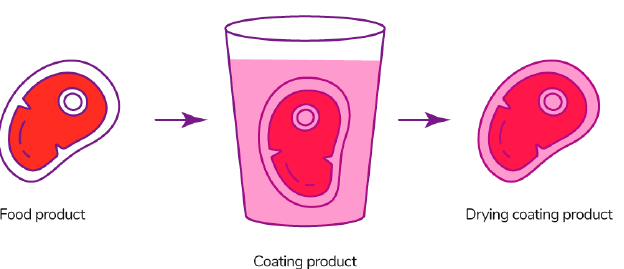
Figure 14. Dipping method [27]. Reproduced with permission from Mohamed, S.A.A., et al., Carbohydrate Polymer; published by Elsevier Ltd., 2020.